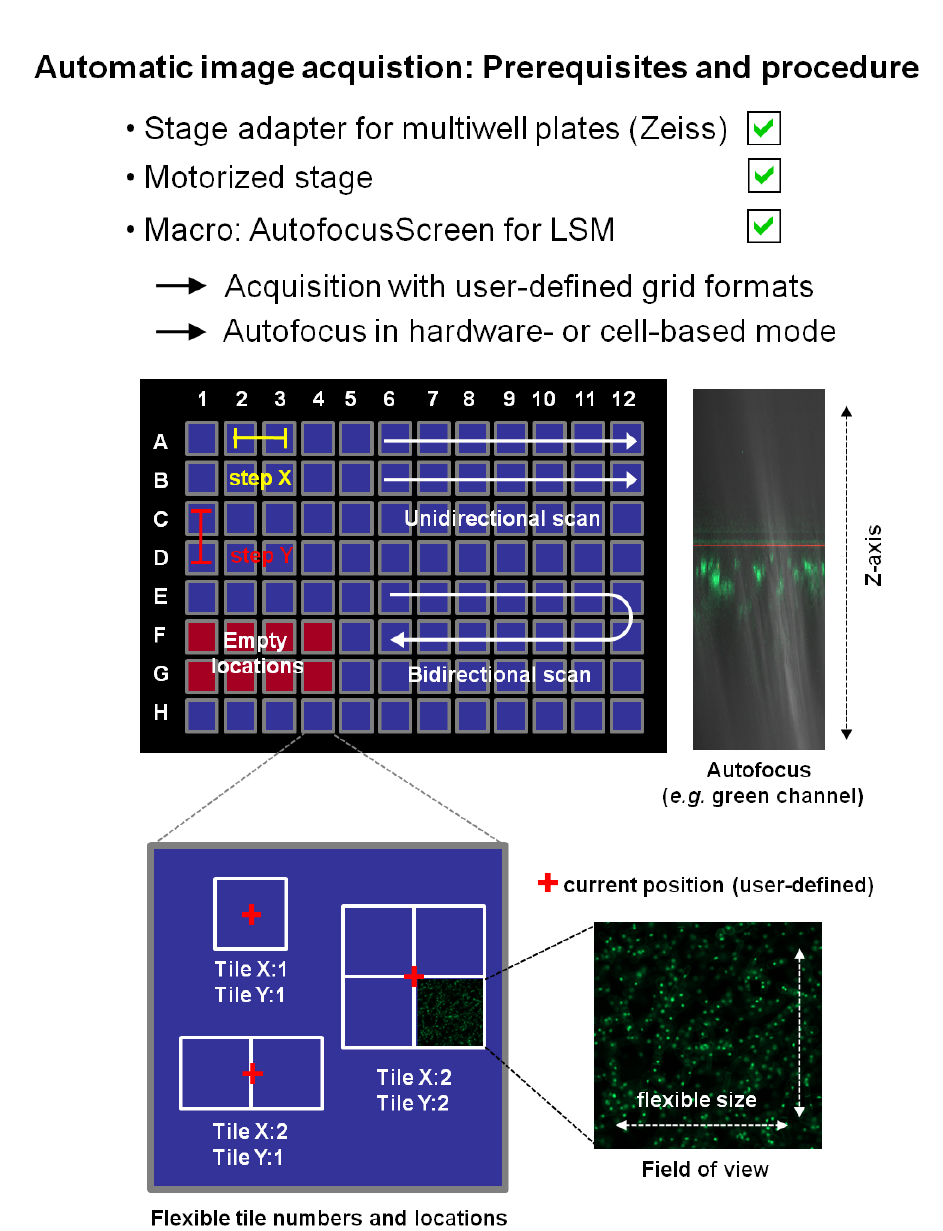
Figure 16. Automatic image acquisition from multiwell plates. Images from multiple locations can be taken using the “AutofocusScreen for LSM” macro, developed in collaboration between Carl Zeiss MicroImaging GMB� (Jena, Germany) and the group of Dr. Jan Ellenberg at the European Molecular Biology Laboratory (EMBL, �eidelberg, Germany). It is freely downloadable at http://www.zeiss.de/LSM-Macros. Well positions selected to be scanned can be defined by simply clicking check boxes. Steps X and Y define the distance between two acquisition locations. The exact position (here marked by a red cross) will be defined by the user, at the beginning of the image acquisition procedure. The user also has the option to define multiple tiles (with no or partial overlap to each other) around this position. The size of the scanned image will also be defined by the user and the scanning settings he chooses. Autofocus can be hardware- or cell-based, acquiring the emitted laser light or the emitted light of the sample respectively (the above shown image displays a cell-based scan across the Z-axis, using the green channel). Initial experiments with tobacco- BY-2 cells however showed that at multiple positions in the Z-axis above the glass bottom, a significant amount of cells could be visualized in the respective focal plane. This factor however will have to be adjusted for the scanning of multiple wells, as BY-2 cells will sediment quite fast (within minutes) to the bottom of the well, resulting in a significant change in the conditions and number of cells in the